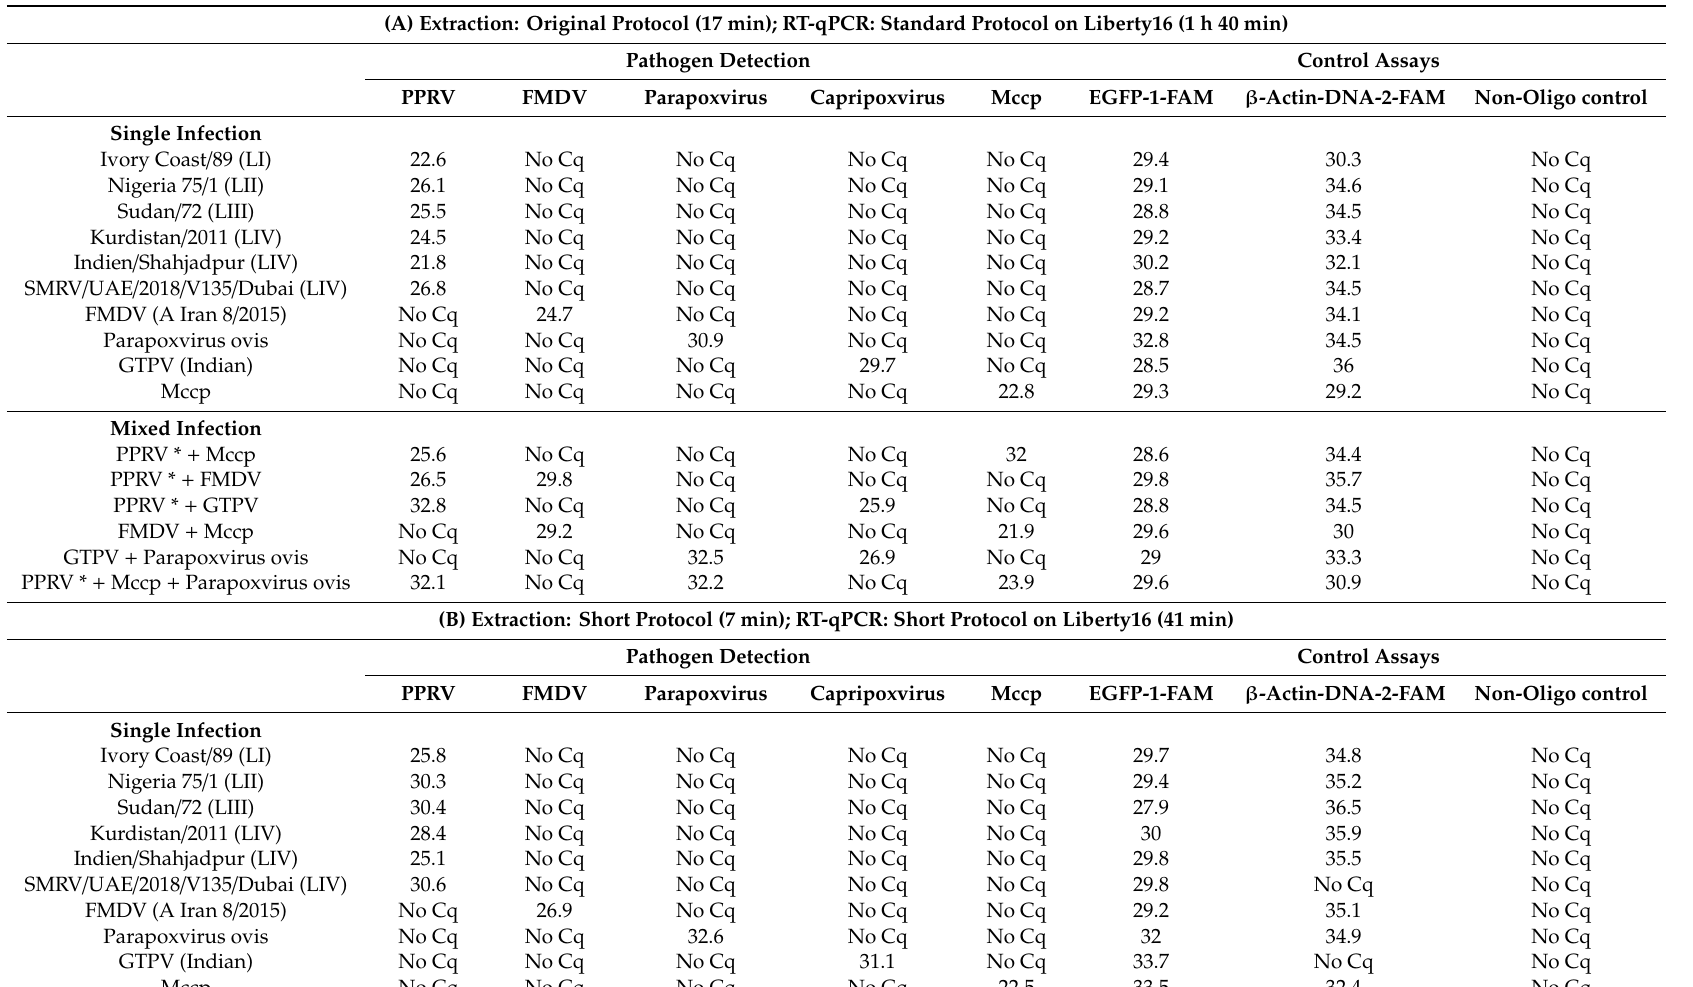
Table 5. Validation of “F ast C heck FLI PPR-like” on the qPCR-cycler Liberty16 (results are shown in Cq-values or as “No Cq” for negative results). (A) Extraction: Original Protocol (17 min); RT-qPCR: Standard Protocol on Liberty16 (1 h 40 min)